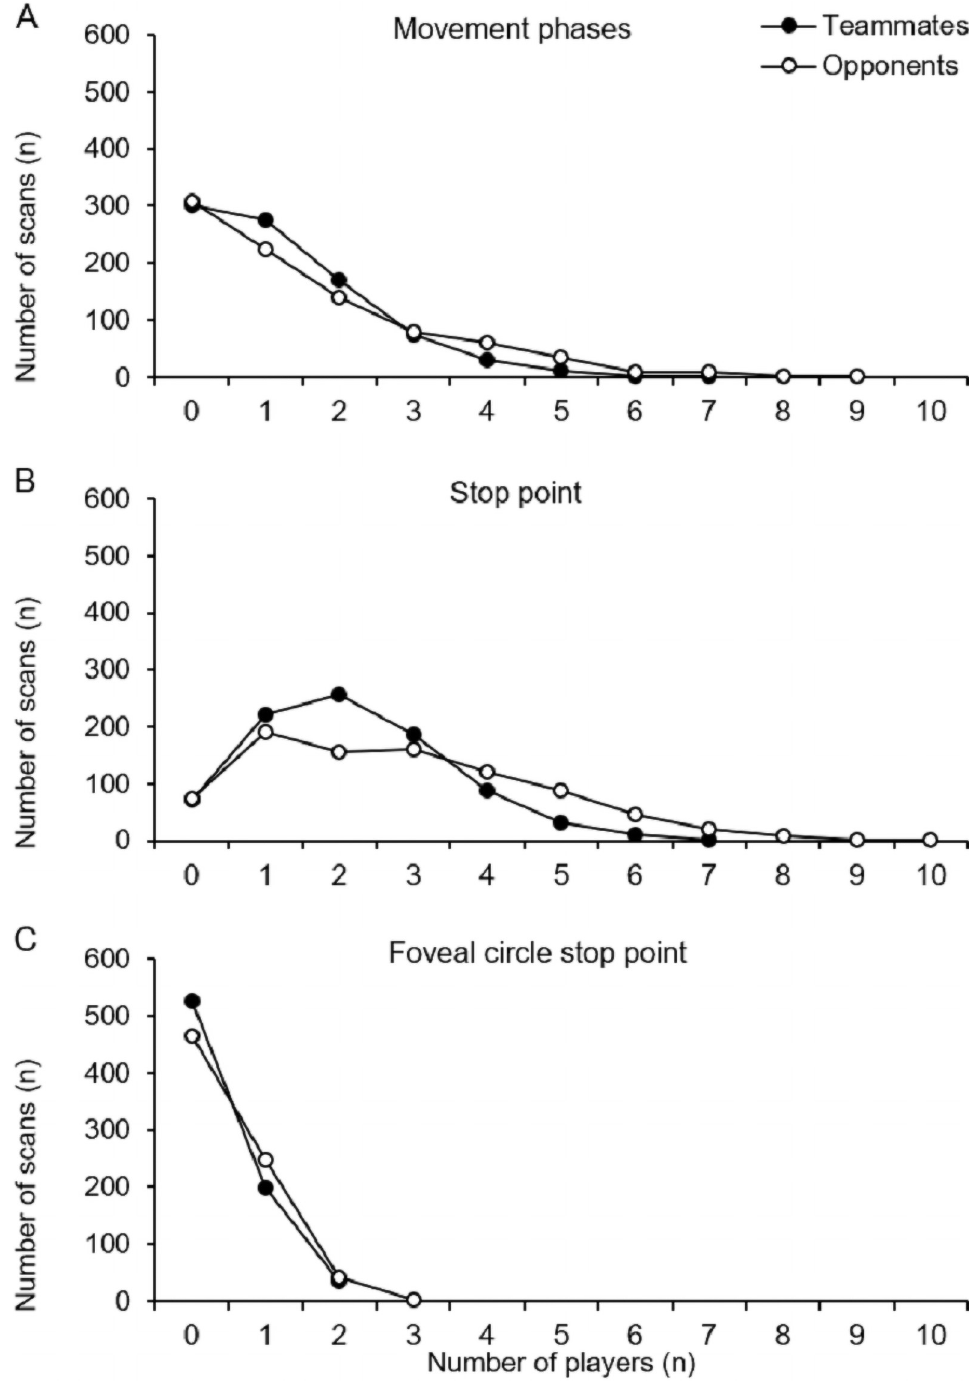
Fig 6. Number of scans on different numbers of opponents and teammates found in the video frame during the movement phases (A), the stop point (B), and the foveal circle stop point (C).